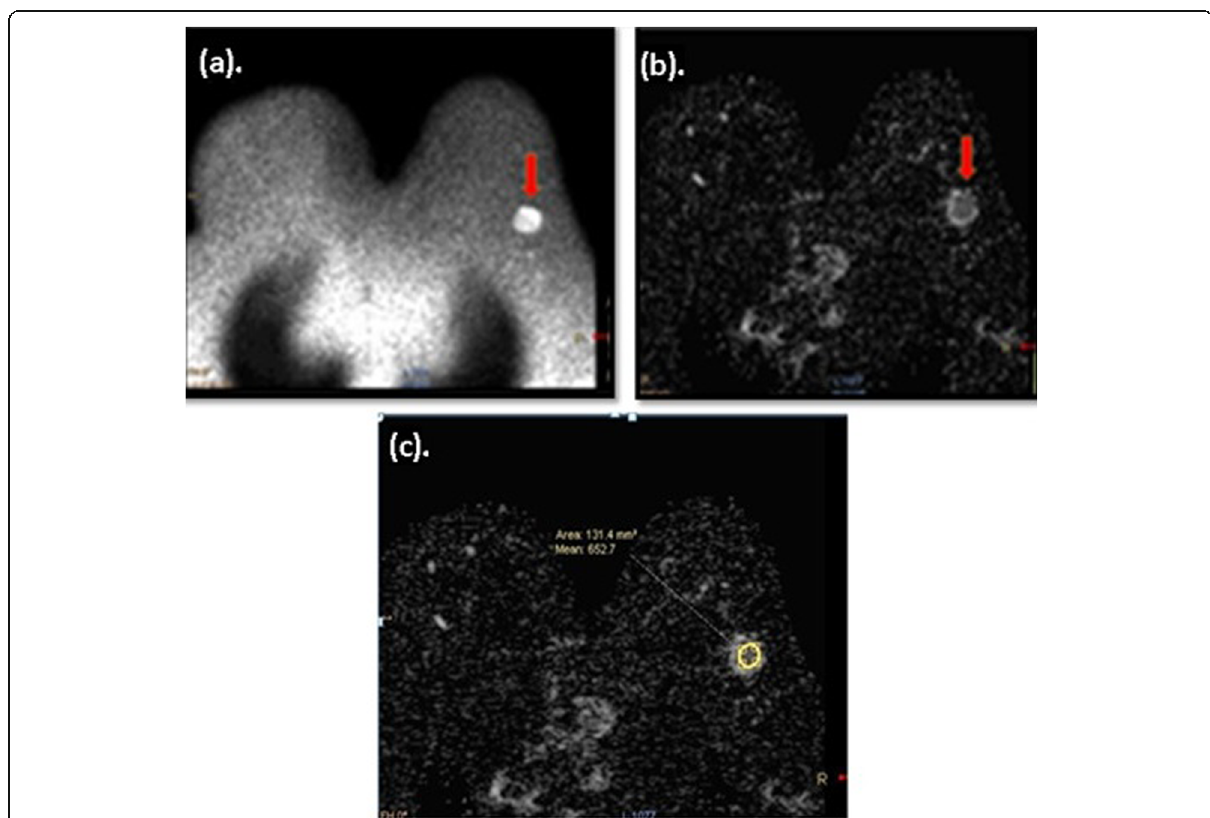
Fig. 4 DWIs analysis. a DWI at b 1500, b ADC map, c ADC value of 0.65 × 10 – 3 mm 2 /s. Left breast axillary tail mass showed restricted diffusion of persistent bright SI on DWI and low SI on ADC map with an estimated ADC value of 0.65 × 10 – 3 mm 2 /s. Pathology and immunohistopathology revealed invasive duct carcinoma, grade III, negative for ER and HER2 and positive for PR receptors